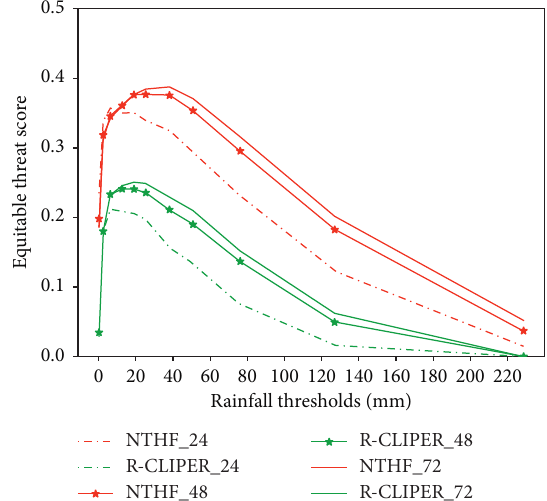
Figure 6: Equitable threat score (ETS) for both systems. Depen- dence of ETS with rainfall thresholds at three forecast times. NTHF always performs better than